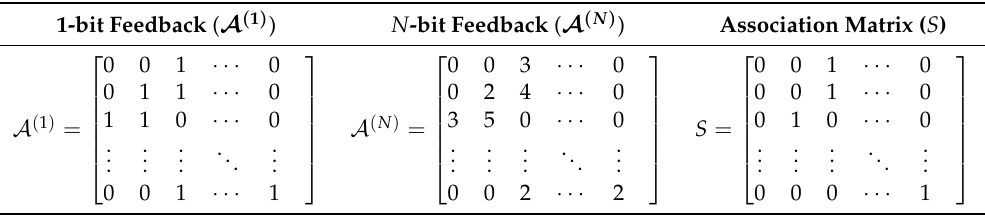
Table 1. Examples of matrices A ( 1 ) , A ( N ) and S